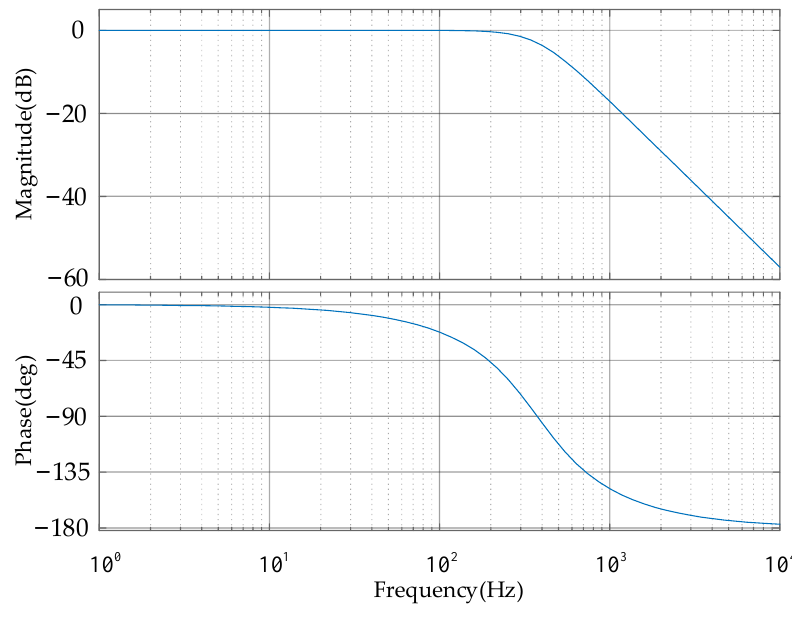
Figure 9. The bode plot of current closed-loop.